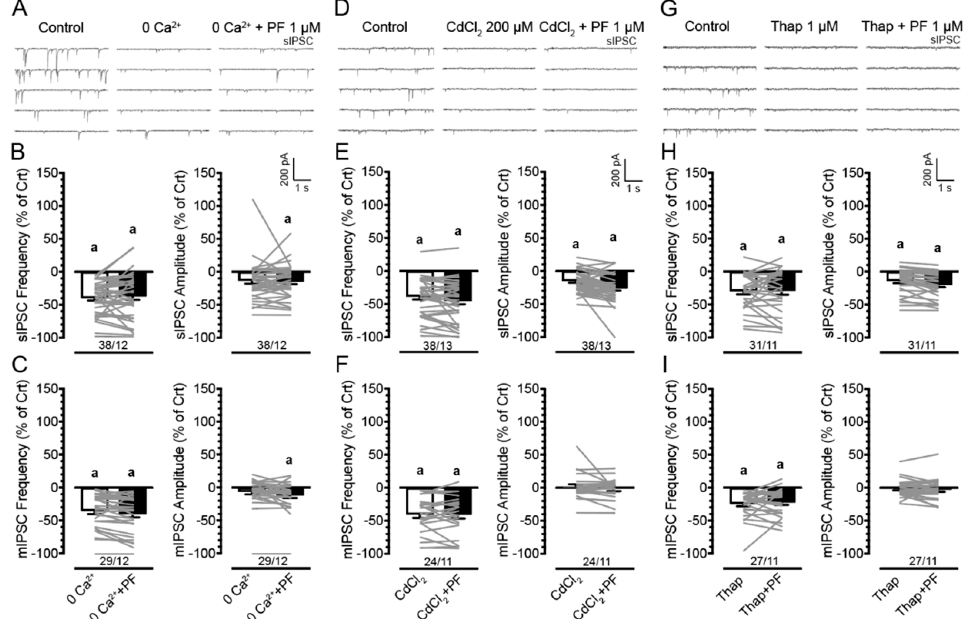
Figure 4. Effects of PF3845 on the frequency and amplitude of IPSCs (% of control) in mPFC neurons are blocked in the absence of extracellular and intracellular calcium. No significant effects were noted for sex and genotype on any sIPSC measure and are therefore collapsed across. ( A ) Representative traces show sIPSCs before and after 0 Ca 2+ ± PF3845 (1 μ M) bath application. ( B ) Removing extracellular calcium from the aCSF in the presence or absence of PF3845 (1 μ M) significantly downregulated sIPSC frequency or amplitude (% of control; except for sIPSC amplitude at 0 Ca 2+ condition) compared to control condition (before removal of 0 Ca 2+ , 0%). Importantly, the 0 Ca 2+ ± PF3845 condition was not significantly different from 0 Ca 2+ , indicating PF3845 had no significant effect on sIPSC frequency or amplitude in the absence of extracellular calcium. ( C ) Similarly, mIPSC fre- quency or amplitude (% of control) was significantly downregulated by 0 Ca 2+ ± PF3845 (except for mIPSC amplitude at 0 Ca 2+ ) with PF3845 showing no further downregulation in the absence of ex- tracellular calcium compared to the 0 Ca 2+ condition. ( D ) Representative traces show sIPSCs before and after CdCl 2 (200 μ M) ± PF3845 (1 μ M) bath application. ( E ) Application of CdCl 2 significantly downregulated sIPSC frequency and amplitude (% of control) in the presence or absence of PF3845 compared to control condition (before CdCl 2 treatment, 0%). No differences were noted between CdCl 2 and CdCl 2 ± PF3845 treatment conditions. ( F ) For mIPSCs, application of CdCl 2 significantly downregulated mIPSC frequency (% of control) from control condition (0%), with CdCl 2 ± PF3845 showing no further downregulation compared to the CdCl 2 condition. No significant differences were noted for mIPSC amplitude (% of control). ( G ) Representative traces show sIPSCs before and after thapsigargin (1 μ M) ± PF3845 (1 μ M) bath application. ( H ) Application of thapsigargin signif- icantly downregulated sIPSC frequency and amplitude (% of control) in the presence or absence of PF3845 compared to control condition (before thapsigargin treatment, 0%). No differences were noted between thapsigargin and thapsigargin + PF3845 treatment conditions, indicating that deple- tion of intracellular calcium stores blocked PF3845 ′ s downregulating effects on sIPSC frequency and amplitude (% of control). ( I ) Similarly, mIPSC frequency was significantly downregulated by thapsigargin, with PF3845 showing no further downregulation compared to thapsigargin alone. No significant differences were noted for mIPSC amplitude (% of control). Data are percent of control data (mean ± SEM) collapsed across sex and genotype. Statistical significance was assessed by ANOVA followed by Bonferroni’s post hoc test and revealed no significant effects. One-sample t -tests with Bonferroni correction assessed significant changes from control condition (0%), a p < 0.05 vs. control (before treatment, 0%). In all panels, sample size is indicated as (cells/mice); please see Supplemental Table S1 for specific information on sample size for sex and genotype. 0 Ca 2+ , zero extracellular calcium; PF, PF3845; Thap,